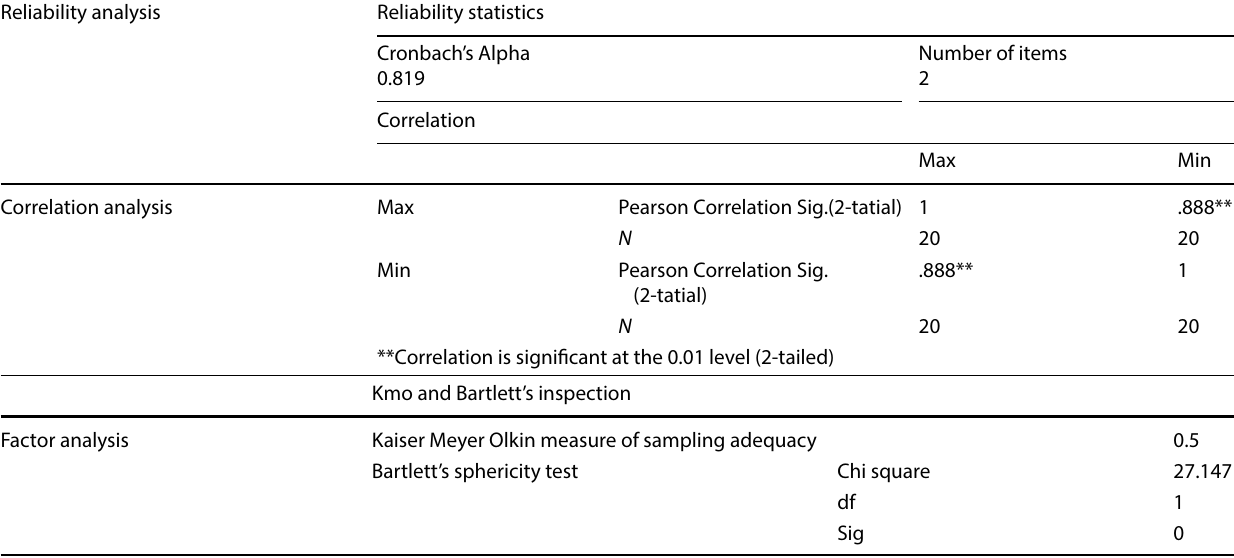
Table 11 Reliability and validity analysis of